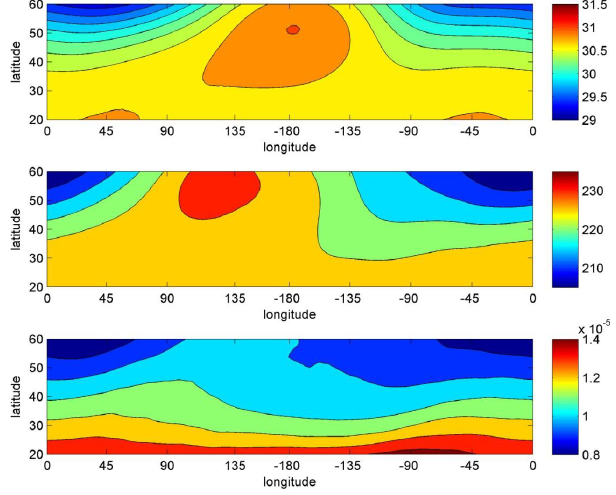
Figure 7. Plot of average geopotential height (km, top panel), tem- perature (K, middle panel) and ozone mixing ratio (ppmv, bottom panel) for January at 20–60 ◦ N, 180 ◦ E–180 ◦ W and